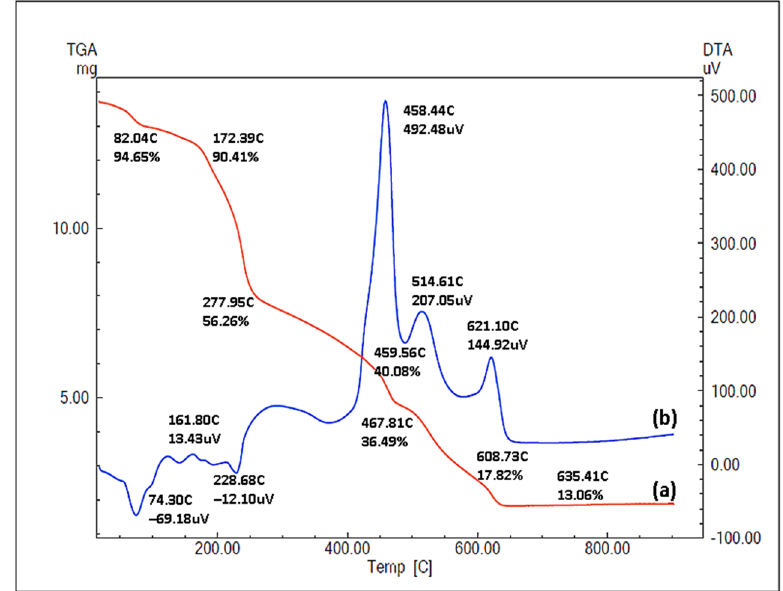
Figure 3. ( a ) TGA and ( b ) DTA curves for [(Cl) 2 Mn(RCOOET)]. The mass losses and the respective gaseous (volatile) product obtained from the TGA curves are collected in Table 2 with the species proposed as mass loss. As can be seen